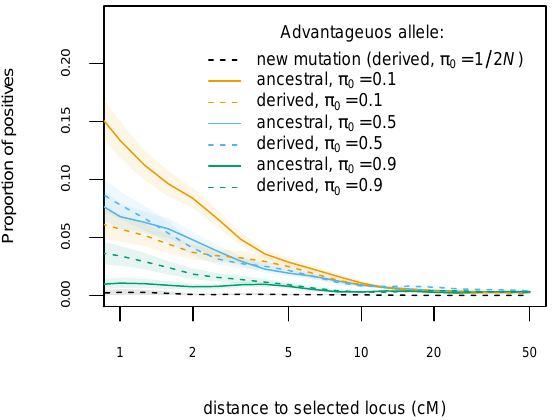
Figure 4 – Influence of derived/ancestral state and initial frequency on selection foot- print. Proportion of positive test in function of distance to the locus under selection. Estimates obtained from 100 replicates of simulated data of one population of N = 500 diploid individuals, sampled twice with τ = 25 generations between samples and selec- tion coefficient s = 0.5 . Adaptation on standing variation, selfing rate σ = 0.95 . 0.00.51.01.52.02.53.0